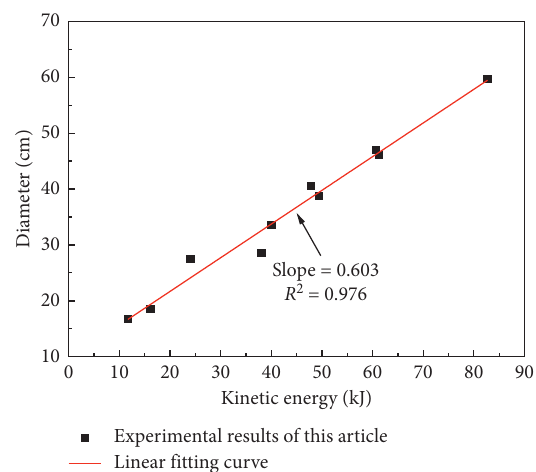
Figure 13: Relation between the kinetic energy of the projectile and the diameter of the final